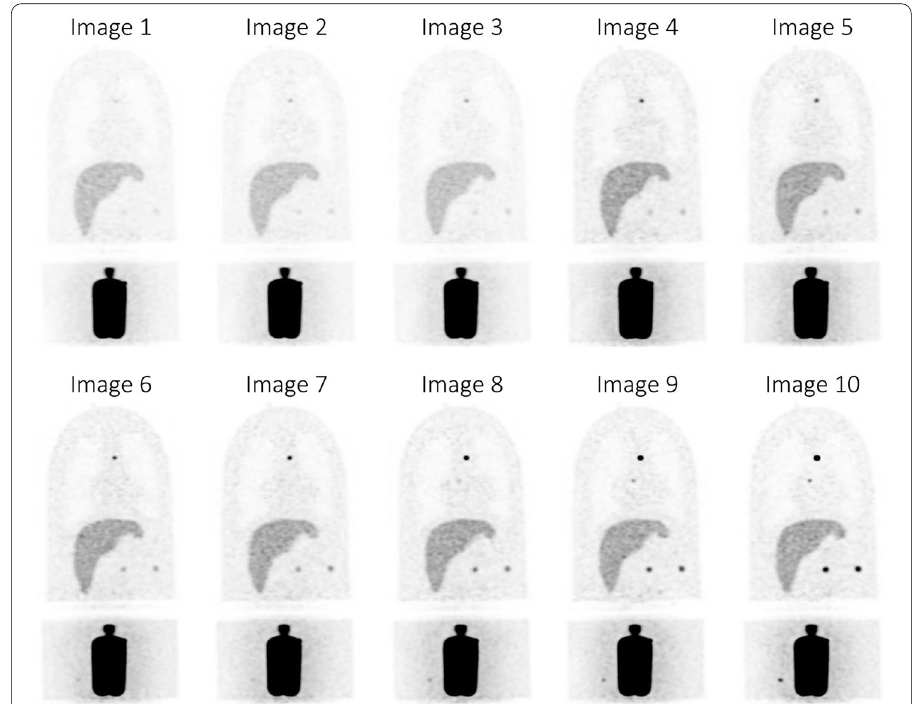
Fig. 3 Maximum intensity projection (MIP) images of the anthropomorphic Probe-IQ phantom. The images show increasing lesion contrast as the 18 F radioactivity in the background decayed (from image 1 to image 10), and the 22 Na lesion radioactivity remained approximately constant